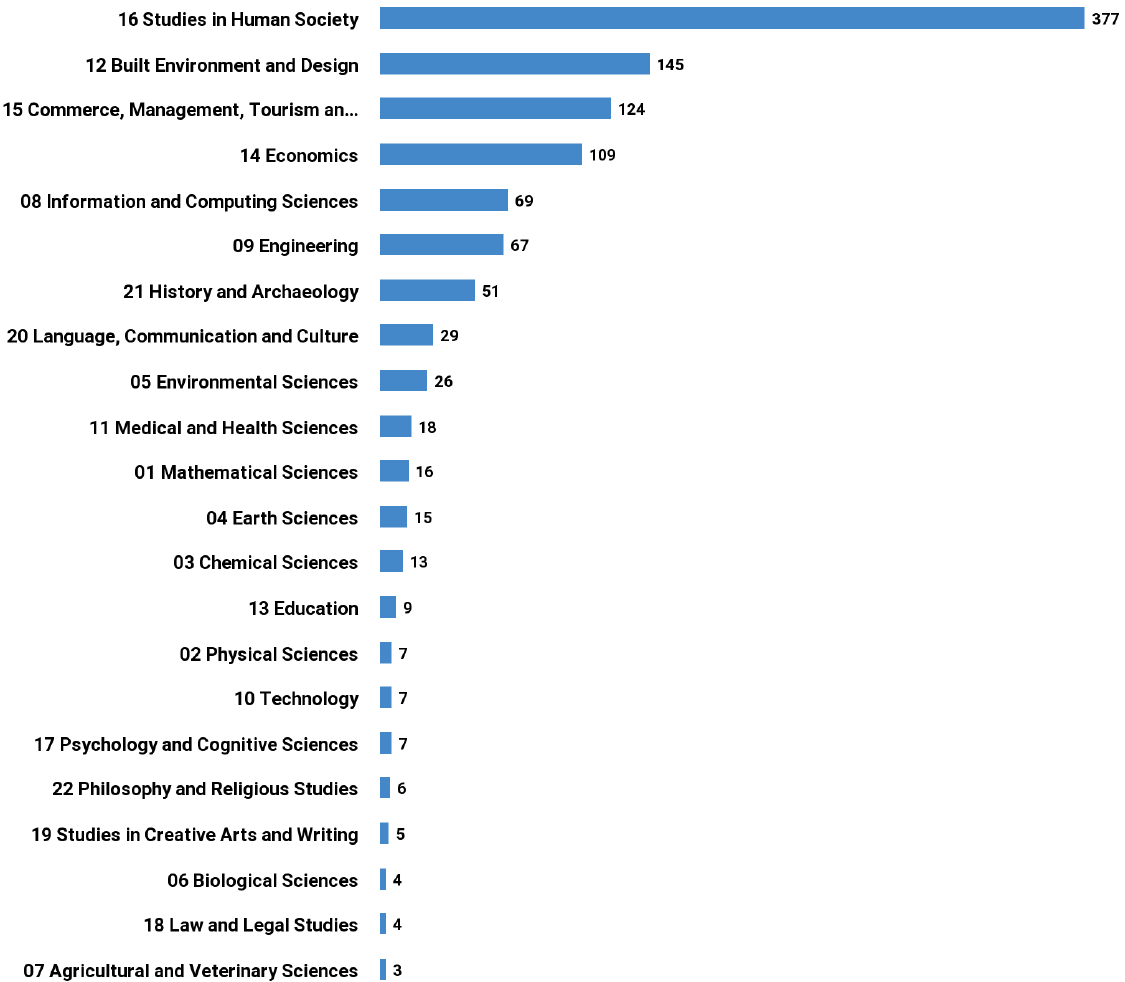
Figure 13 . Distribution by Field of Research (Dimensions AI) . Figure 13. Distribution by Field of Research (Dimensions